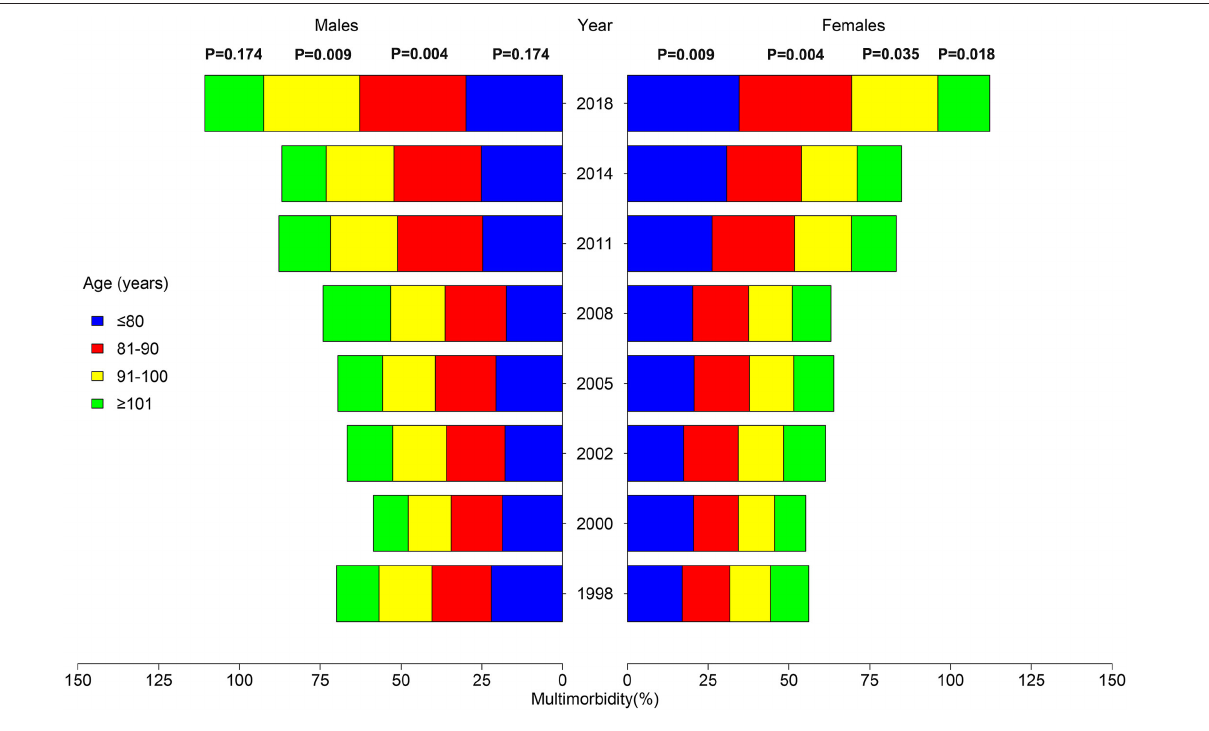
FIGURE 2 | Pyramid of multimorbidity by gender and age